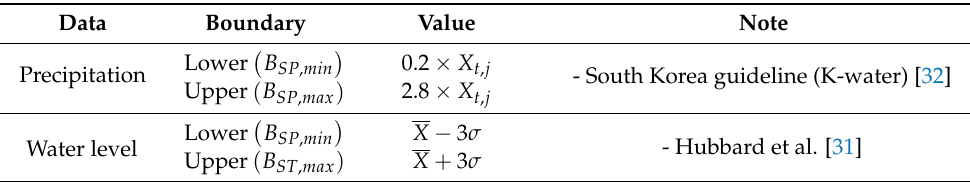
Table 5. Validation boundaries applied for spatial check